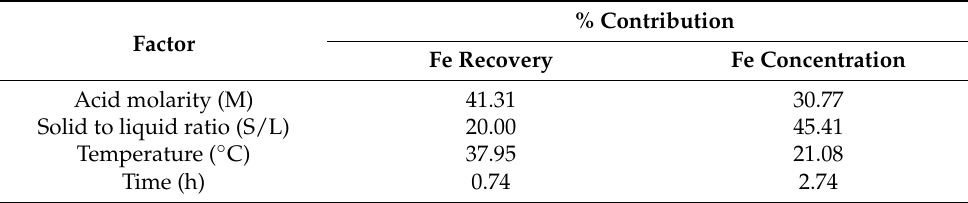
Table 4. % factors contribution for Fe recovery and